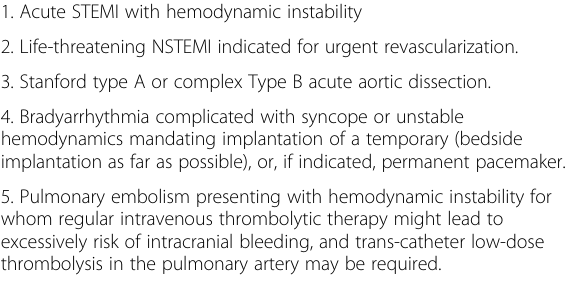
Table 4 Severe cardiovascular diseases requiring urgent or emergent intervention or